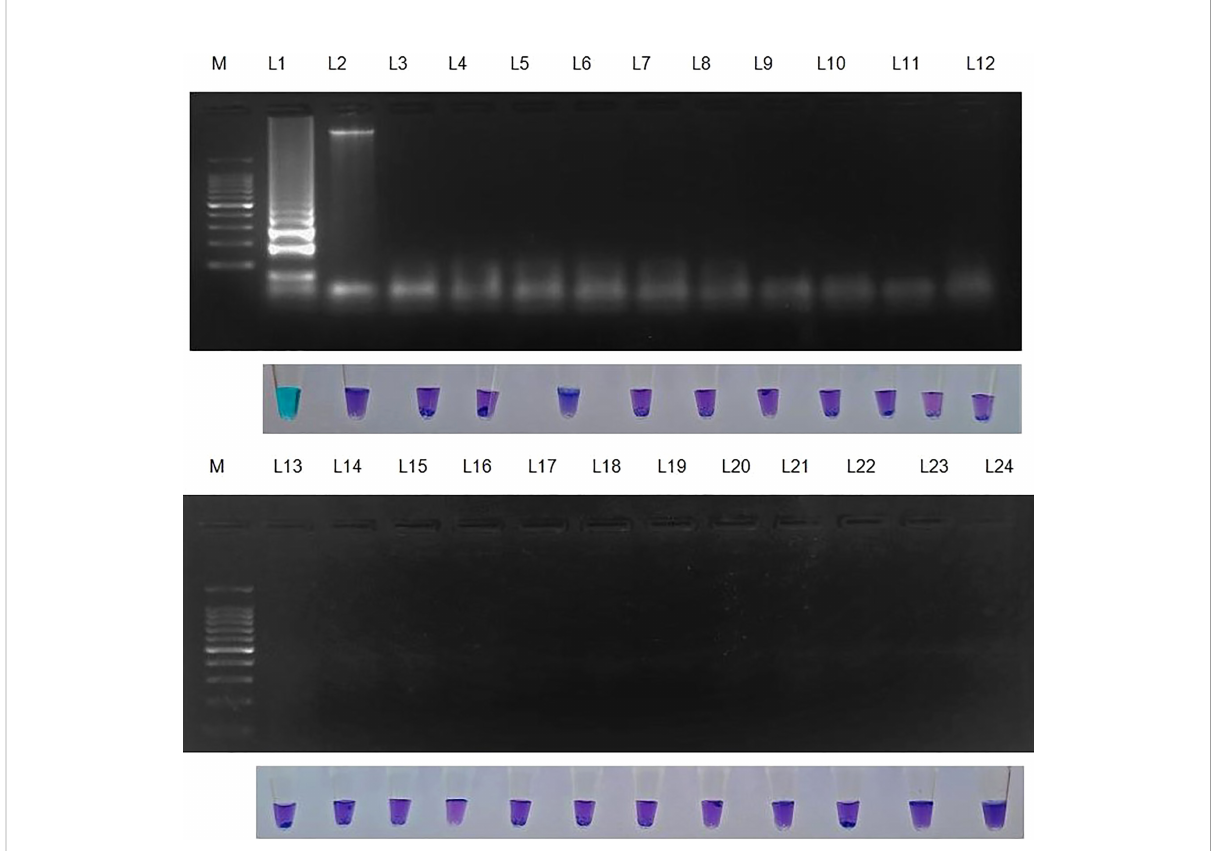
FIGURE 4 Speci fi city of LAMP assay using Sarocladium oryzae isolate OM841519 as template and nuclease free water as negative control. Upper panel in the fi gure shows agarose gel electrophoresis results whereas lower panel shows reaction tubes for colorimetric detection. M- 100bp Ladder; Lane 1: Sarocladium oryzae ; Lane 2: Sarocladium attenuatum ; Lane3: Sarocladium strictum; Lane 4: Bipolaris oryzae ; Lane 5: Magnaporthe oryzae ; Lane 6: Rhizoctonia solani ; Lane 7: Ustilaginoidea virens ; Lane 8: Exserohilum rostratum ; Lane 9: Simplicillium obclavatum ; Lane 10: Pyricularia grisea ; Lane 11: Helminthosporium turcicum ; Lane 12: Macrophomina phaseolina ; Lane 13: Sclerotium rolfsii ; Lane 14: Sclerotinia sclerotiorum ; Lane 15: Colletotrichum gloeosporioides ; Lane 16: C. scovillea ; Lane 17: C. truncatum ; Lane 18: Fusarium oxysporum f. sp. cubense ; Lane 19: Phytophthora infestans ; Lane 20: Puccinia arachidis ; Lane 21: Uncinula nector ; Lane 22: Pantoea dispersa ; Lane 23: Ralstonia solanacearum ; Lane 24: Nuclease free water (Negative